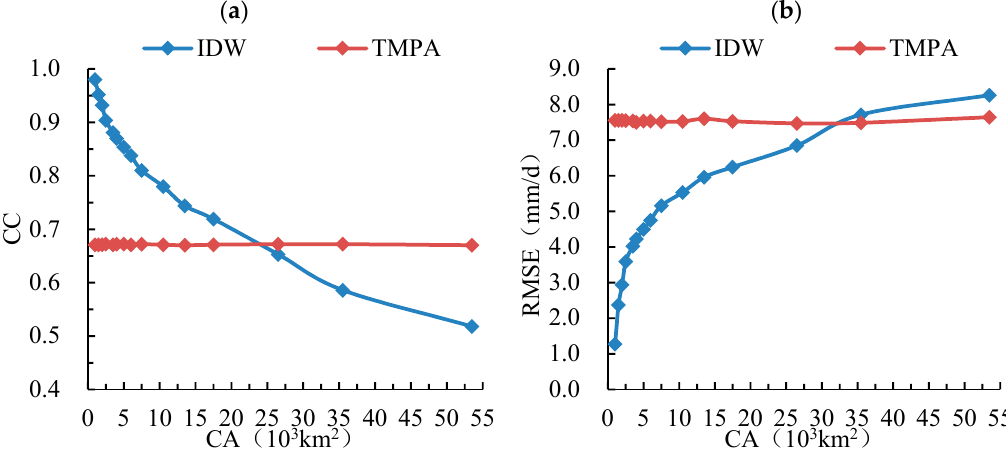
Figure 3. Correlation coefficients (CC) ( a ) and root-mean-square errors (RMSE) ( b ) of the standard data and two precipitation products (the inverse distance weight method (IDW) and Tropical Rainfall Measuring Mission (TRMM) Multi-Satellite Precipitation Analysis (TMPA)) for different average areas controlled by a single station. CA in the figure means the average area controlled by a single station.